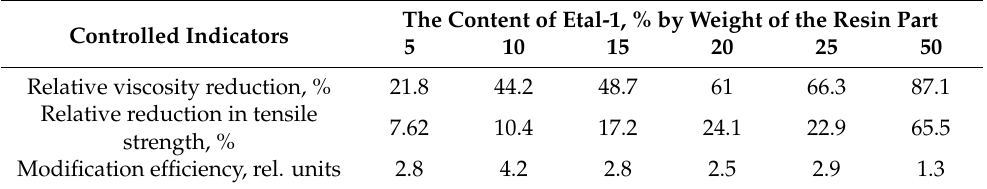
Table 3. Evaluation of the effectiveness of modifying the epoxy resin ED ‐ 20 with an aliphatic dil ‐ uents of the brand Etal ‐ 1.